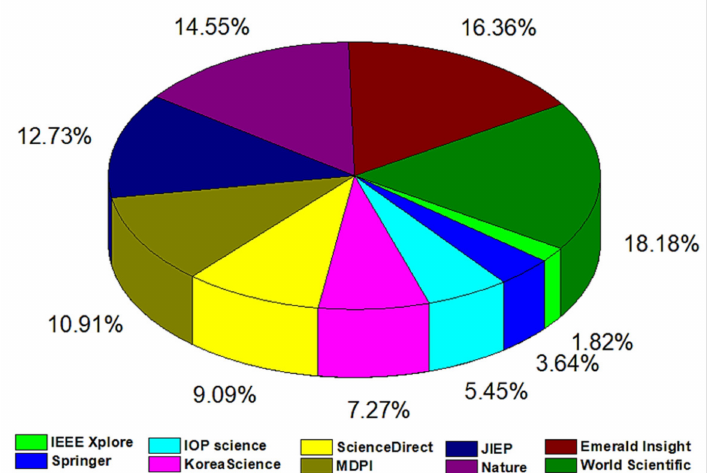
Figure 3. Publishers included in the present work.